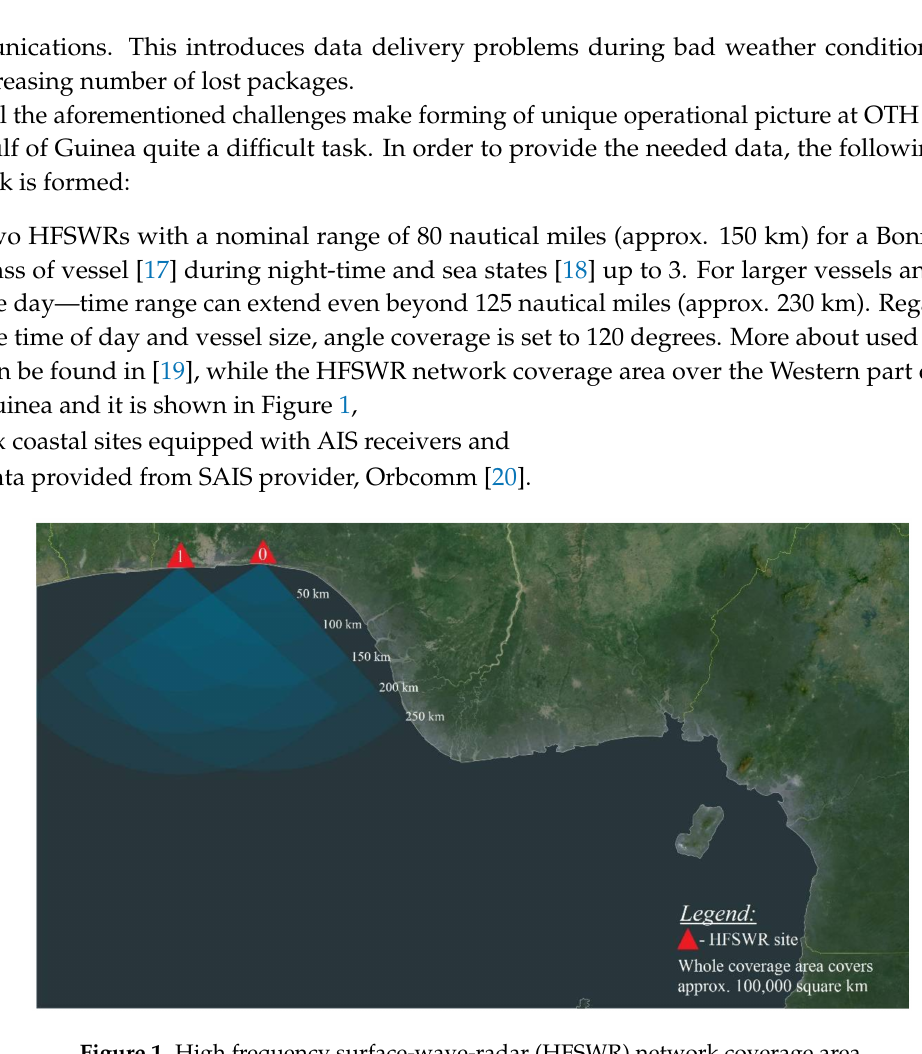
Figure 1. High frequency surface-wave-radar (HFSWR) network coverage